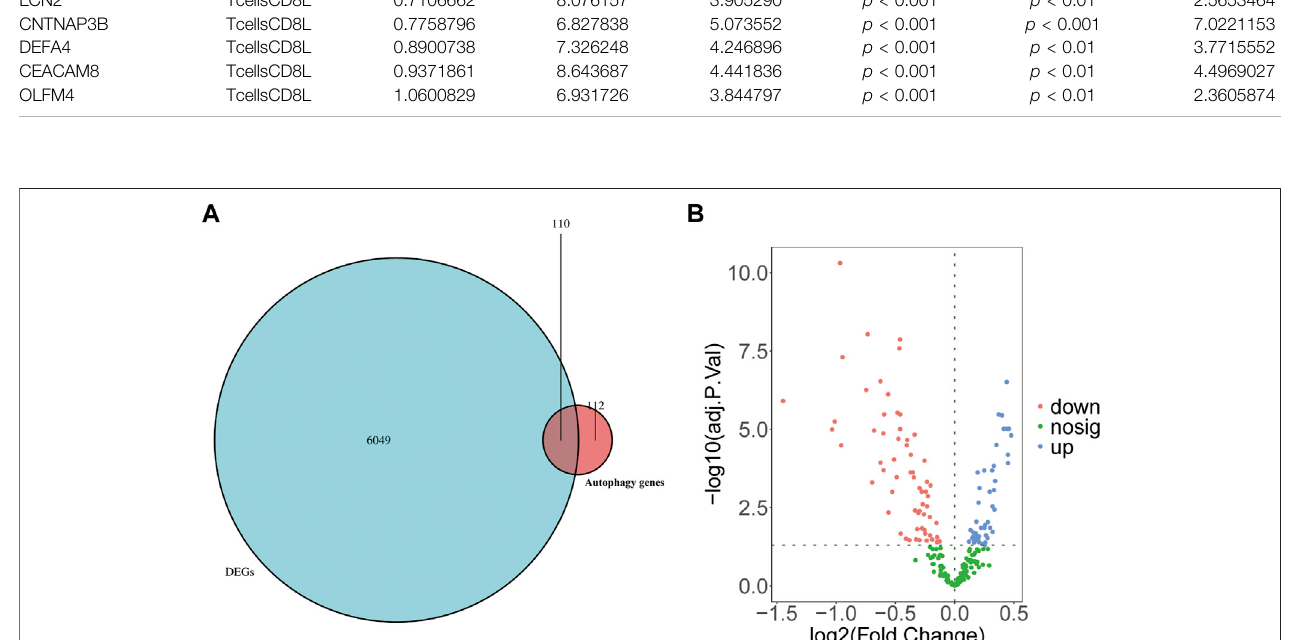
FIGURE 5 | Identi fi cation of ARMGs in the T cell CD8H cluster. (A) Venn diagram showed the intersecting genes (denoted as ARMGs) from marker genes of T cell CD8H cluster (denoted as DEGs) and ARGs of HADb. Blue-Green area: marker genes of T cell CD8H cluster; red area: ARGs of HADb; cross area: genes expressed in both gene sets. (B) Volcano plot of the 110 ARMGs in the T cell CD8H cluster. Blue: upregulation with adj. p < 0.05; red: downregulation with adj. p < 0.05; green: unchanged genes. ARMGs, autophagy-related marker genes; DEG, differentially expressed gene; ARGs, autophagy-related genes; HADb, Human Autophagy